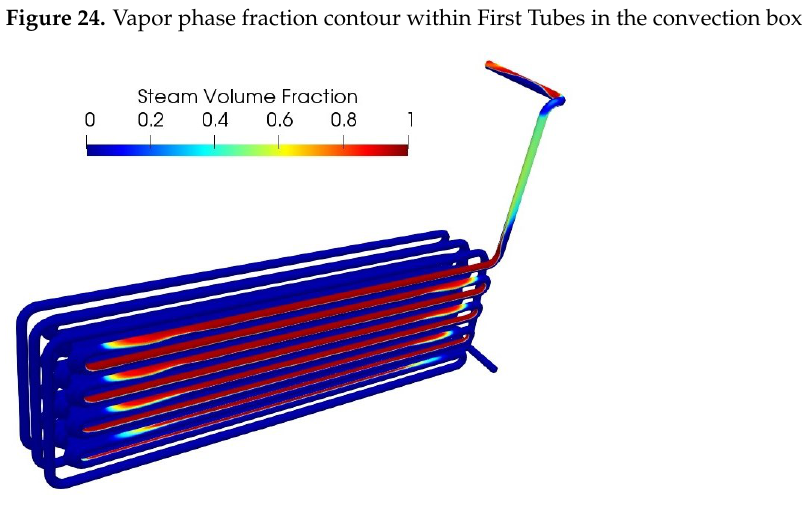
Figure 25. Vapor phase fraction contour within First Tubes in the convention box-whole pipes.